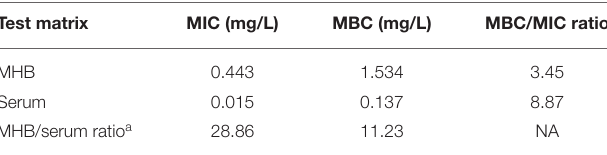
TABLE 1 | Geometric mean minimum inhibitory concentrations (MICs) and minimum bactericidal concentrations (MBCs) in broth and porcine serum and MBC/MIC and Mueller-Hinton broth (MHB)/serum ratios for gamithromycin against selected Streptococcus suis isolates ( n =